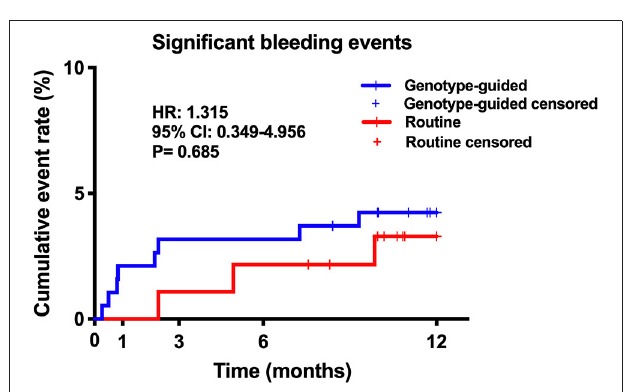
FIGURE 4 | Kaplan–Meier curve of significant bleeding events during 12-month follow-up. Significant bleeding events: Bleeding Academic Research Consortium (BARC) class 2 or